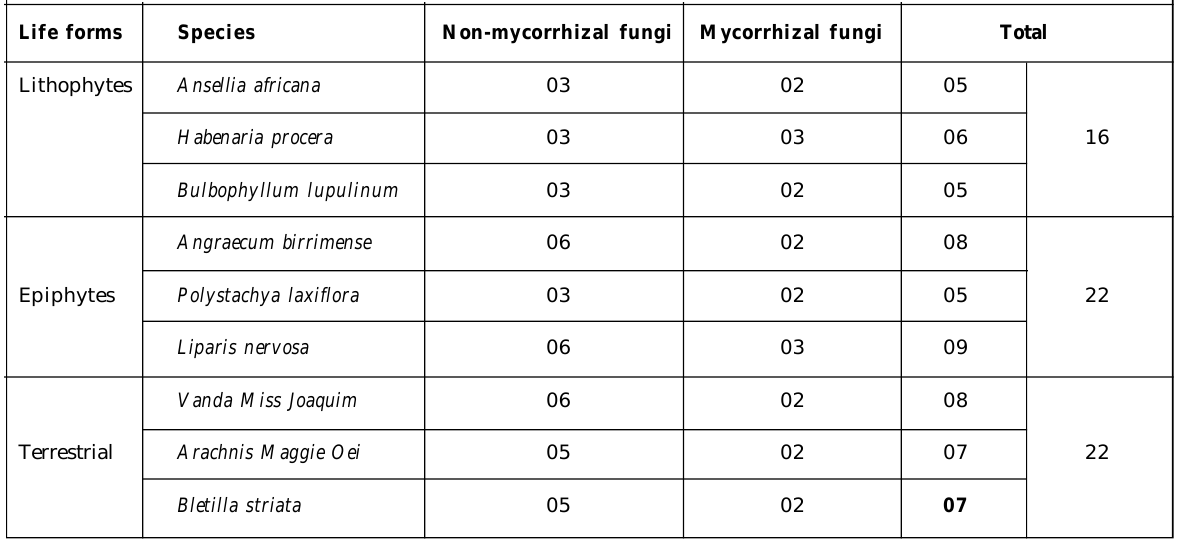
Table 3: Abundance of fungal endophytes in the different orchid life forms in the MCR Life forms Species Non-mycorrhizal fungi